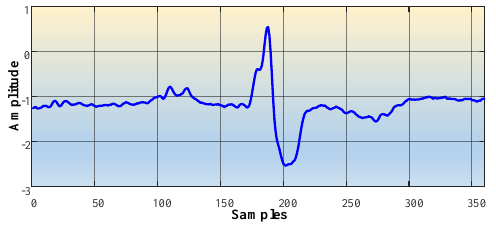
Figure 5. RBBB arrhythmia signal example.